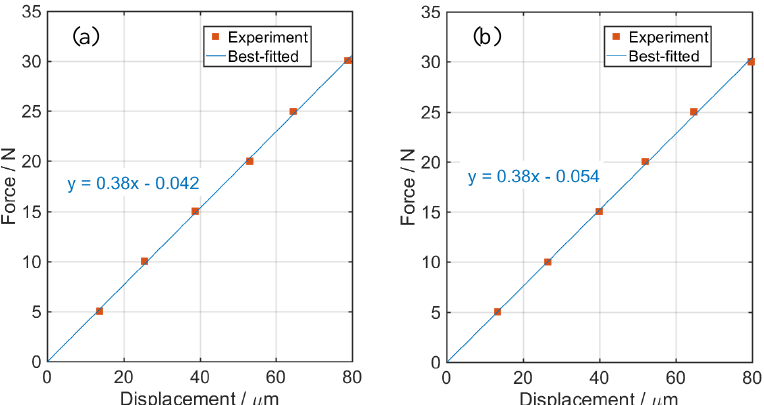
Figure 9. Relationship between applied force and resulting displacement for ( a ) the x -axis and ( b ) the y